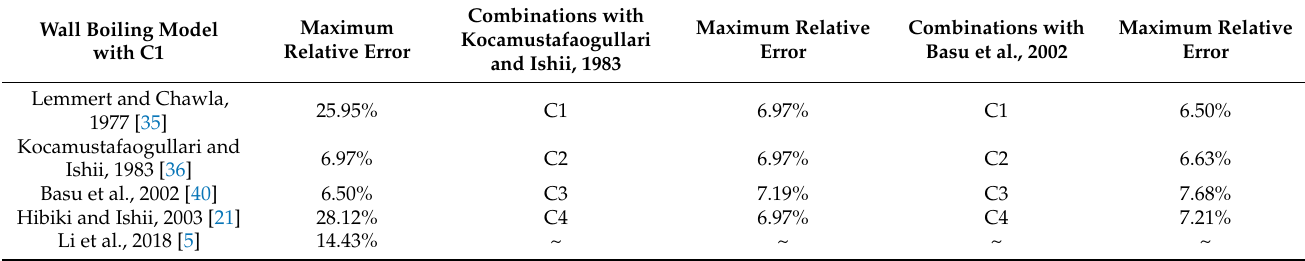
Table 11. Maximum relative errors between numerical results of j l with DEBORA-1 experiment data ( P = 2.62 MPa) for first loop of NPP ( P = 15.70